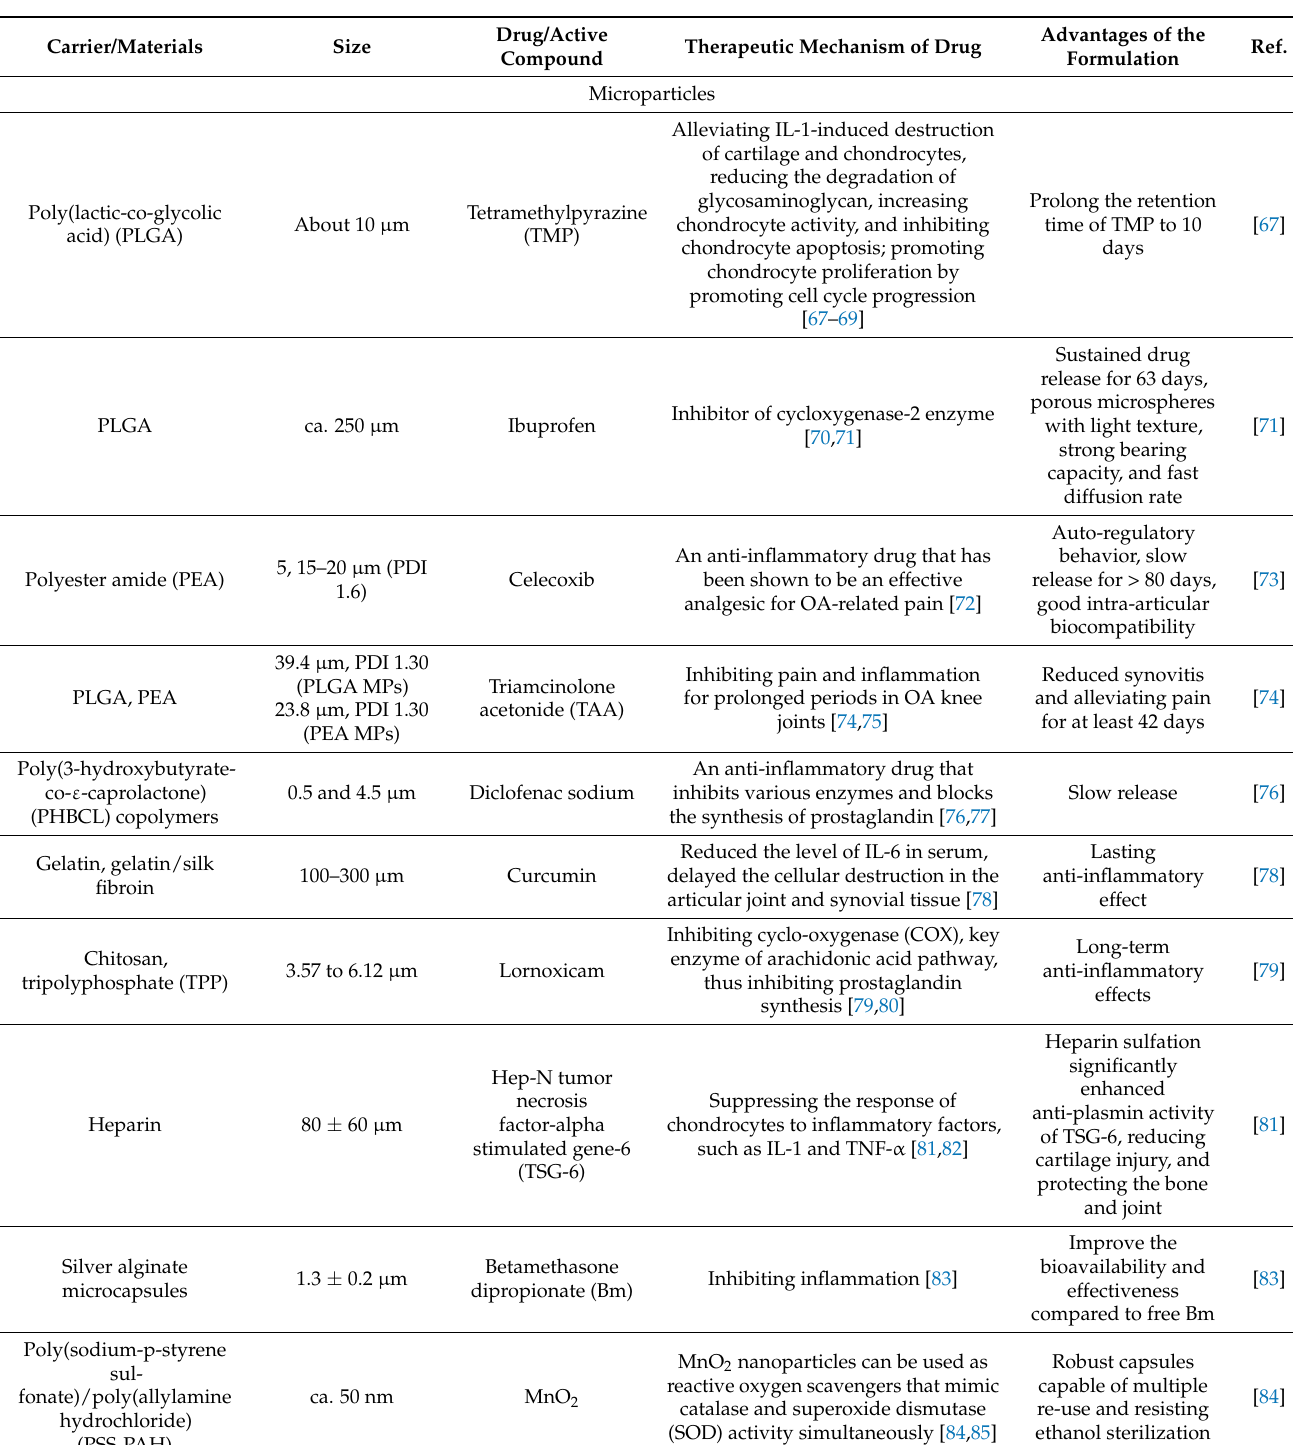
Table 1. Summary of information on different drug delivery systems investigated over the past five years.